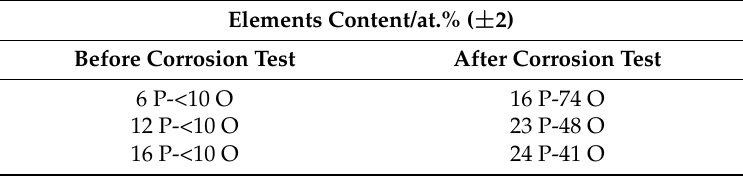
Figure 8. Surface morphology (SEM images) of the Fe-16 at.% P alloy before ( a ) and after ( b ) the potentiodynamic corrosion test in 0.5 M H 2 SO 4 . Table 4. P and O content of Fe-P alloys before and after corrosion testing in 0.5 M H 2 SO 4 for 1 h (comp. Figure 7). Determined by SEM-EDX.